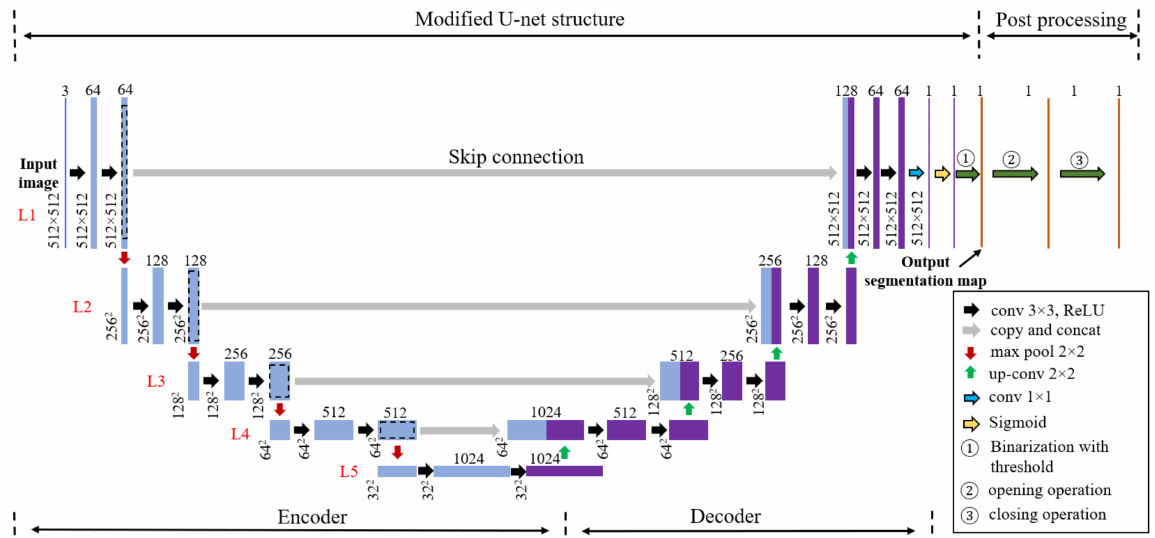
Figure 1. Overview of the proposed method for fatigue crack segmentation (modified from the original U-net [36], copyright Springer,